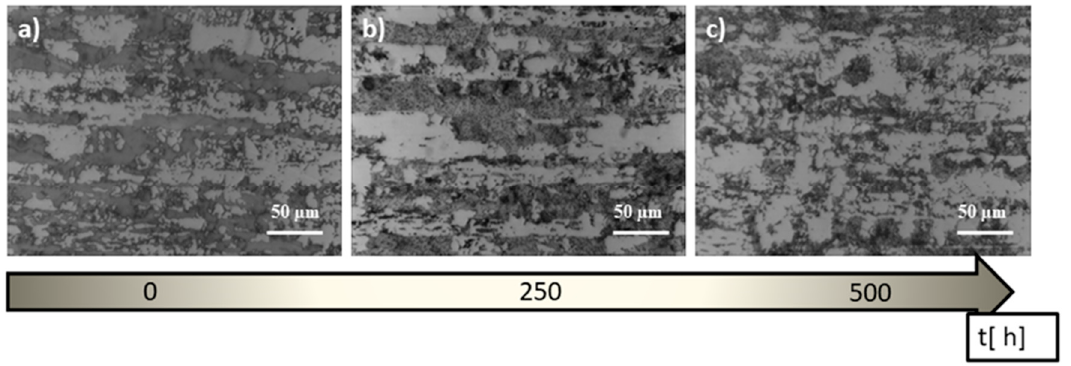
Figure 4. Microstructure of 1.4462 steel: ( a ) before annealing, ( b ) after annealing at 600 ◦ C, 250 h, ( c ) after annealing at 600 ◦ C, 500 h.